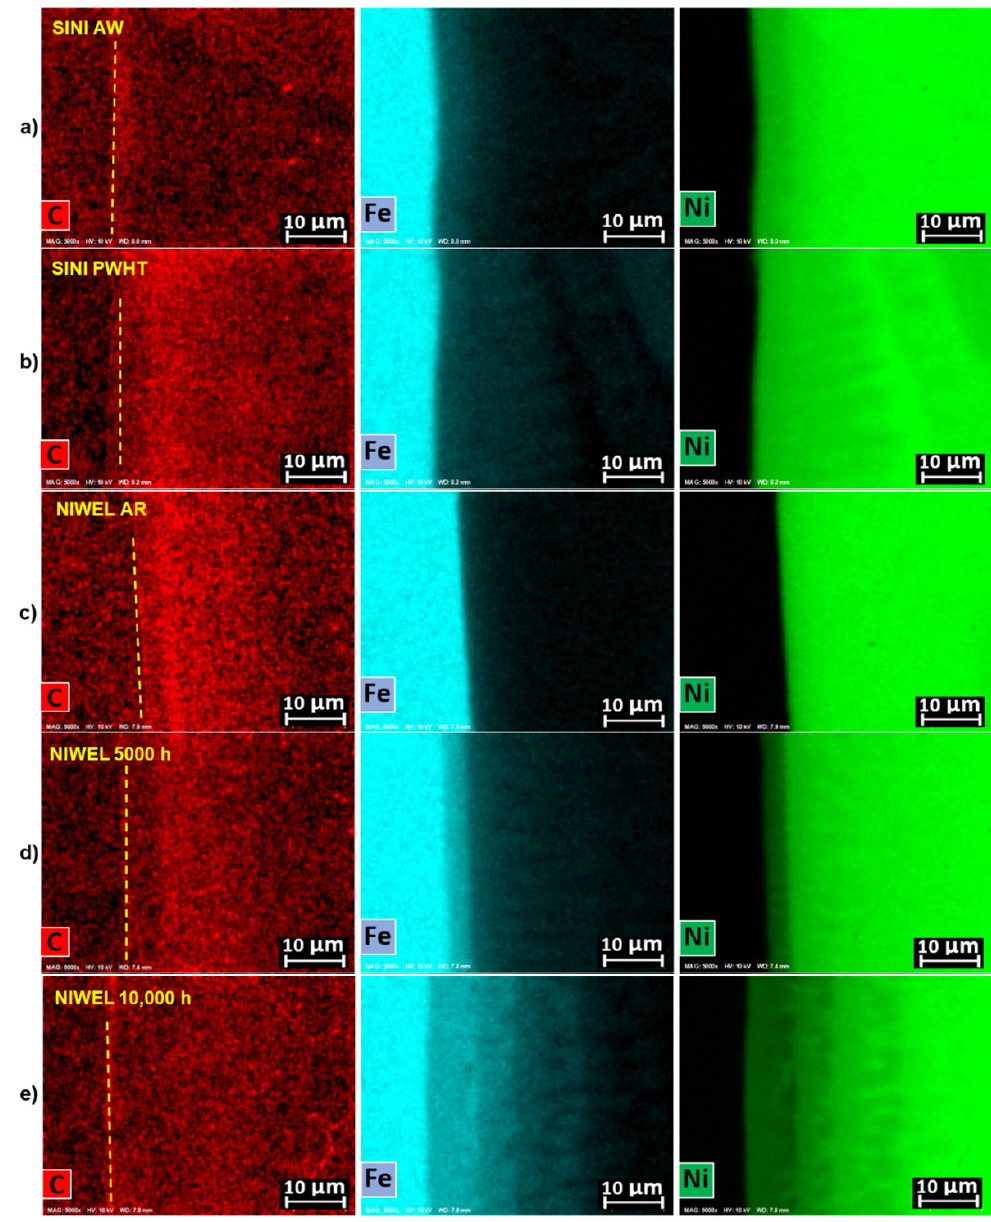
Figure 10. EDS maps over the FB (highlighted with a yellow dash line) in ( a ) SINI AW, ( b ) SINI PWHT, ( c ) NIWEL AR, ( d ) NIWEL 5000 h and ( e ) NIWEL 10,000 h conditions, showing changes in composition gradients of carbon, iron and nickel.